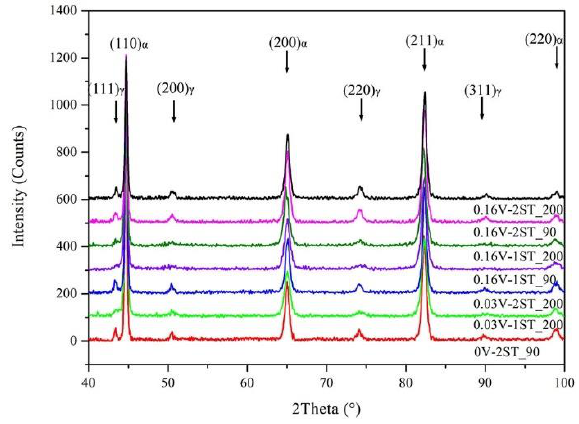
Figure 9. XRD patterns of the Q&P-treated specimens.